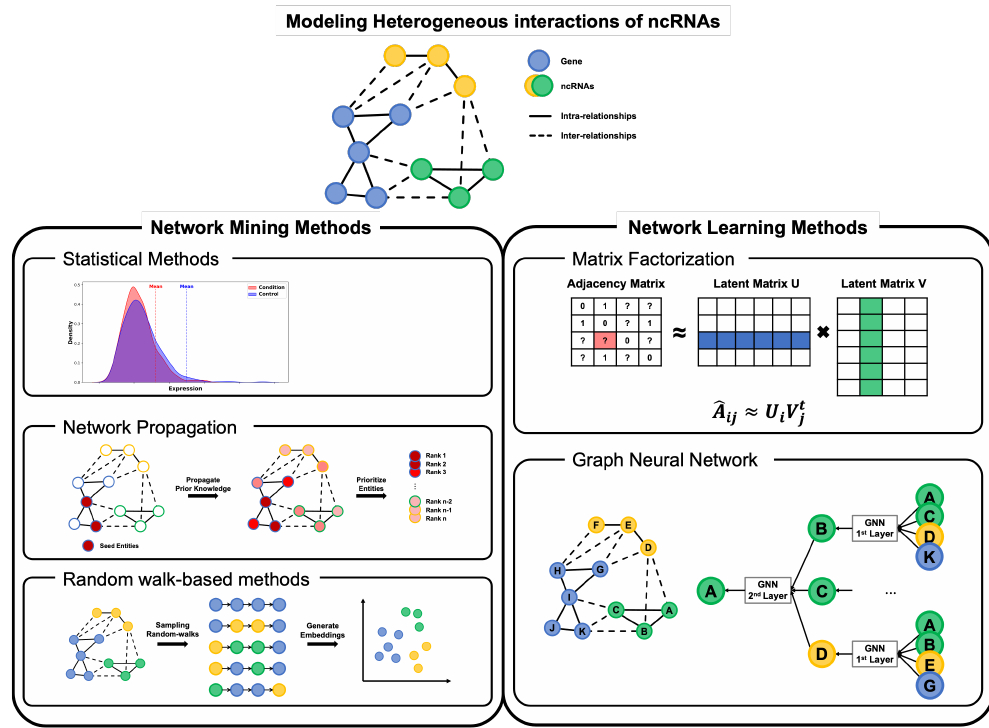
Figure 2. Two methodologies for investigating the relationship between ncRNA and other biological entities; network mining methods (statistical methods, network propagation, random walk-based methods) and deep learning methods (matrix factorization, graph neural